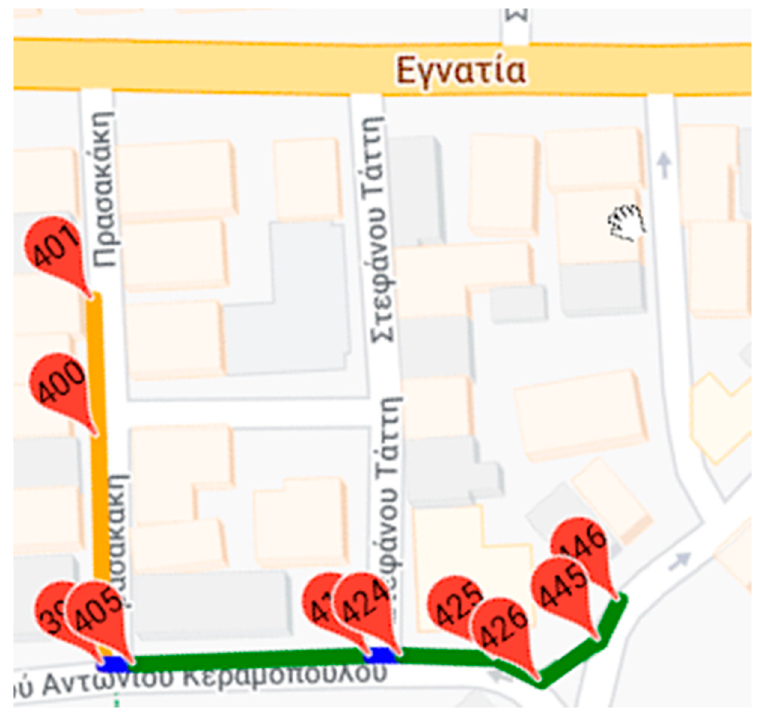
Figure 7. Shortest path between nodes 401 and 446 and also most accessible path between nodes 401.